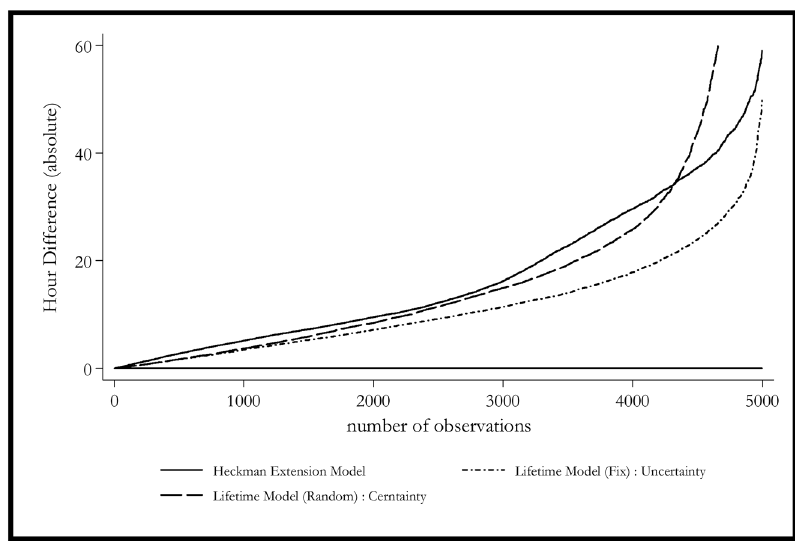
Figure 2. Simulation Residuals – Selected Models (2004–2005). olid Line: Heckman Selection Model. Dash Line: Lifetime Model (Random Coefficient): Certainty. Dash-Dot Line: Lifetime Model (Fix Coefficient): Uncertainty.